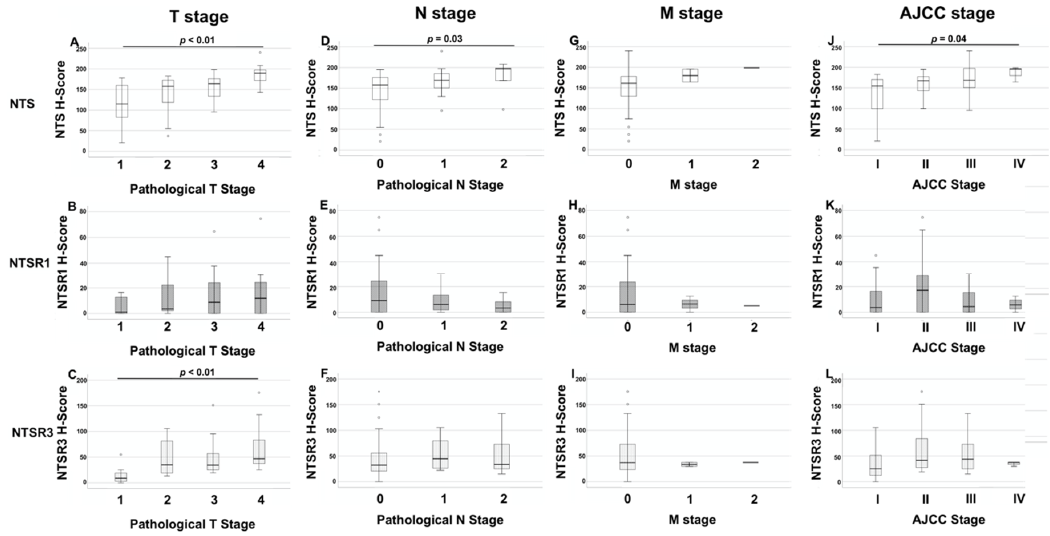
Figure 3. Column 1: H-scores of staining of NTS ( A ), NTSR1 ( B ), and NTSR3 ( C ) across American Joint Committee on Cancer (AJCC) pathological T grades. Column 2: H-scores of staining of NTS ( D ), NTSR1 ( E ), and NTSR3 ( F ) across AJCC pathological N grades. Column 3: H-scores of staining of NTS ( G ), NTSR1 ( H ), and NTSR3 ( I ) across AJCC M grades. Column 4: H-scores of staining of NTS ( J ), NTSR1 ( K ), and NTSR3 ( L ) across AJCC clinical stages for colorectal cancer. Solid line: median, ends of boxes: inter-quartile range, error bars: range, circles and asterisks: outliers. Significant p values shown for Independent samples Kruskal-Wallis test. Circle: Outliers (values between than 1.5–3 times inter-quartile range). Asterix: Extreme values (values more than 3 times the inter-quartile range).